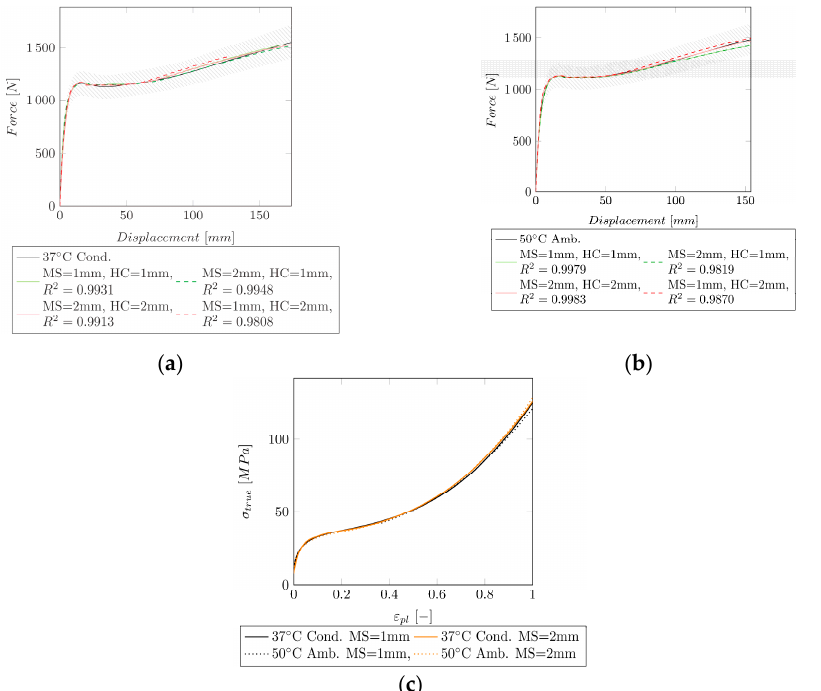
Figure 8. Comparison of the experimental data to the simulation of Group II for two mesh sizes (MS = 1 mm and MS = 2 mm). HC = 1 mm: HC identified with MS = 1 mm, HC = 2 mm: HC identified with MS = 2 mm. The shaded area indicates a ±10% force region around the experimental curve. ( a ) Experimental and simulated force–displacement curves at 37 ◦ C (conditioned) with the extended Hockett–Sherby model including the resulting R 2 . ( b ) Experimental and simulated force–displacement curves at 50 ◦ C (ambient) with the extended Hockett–Sherby model including the resulting R 2 . ( c ) HCs for the extended Hockett–Sherby model for an MS of 1 and 2